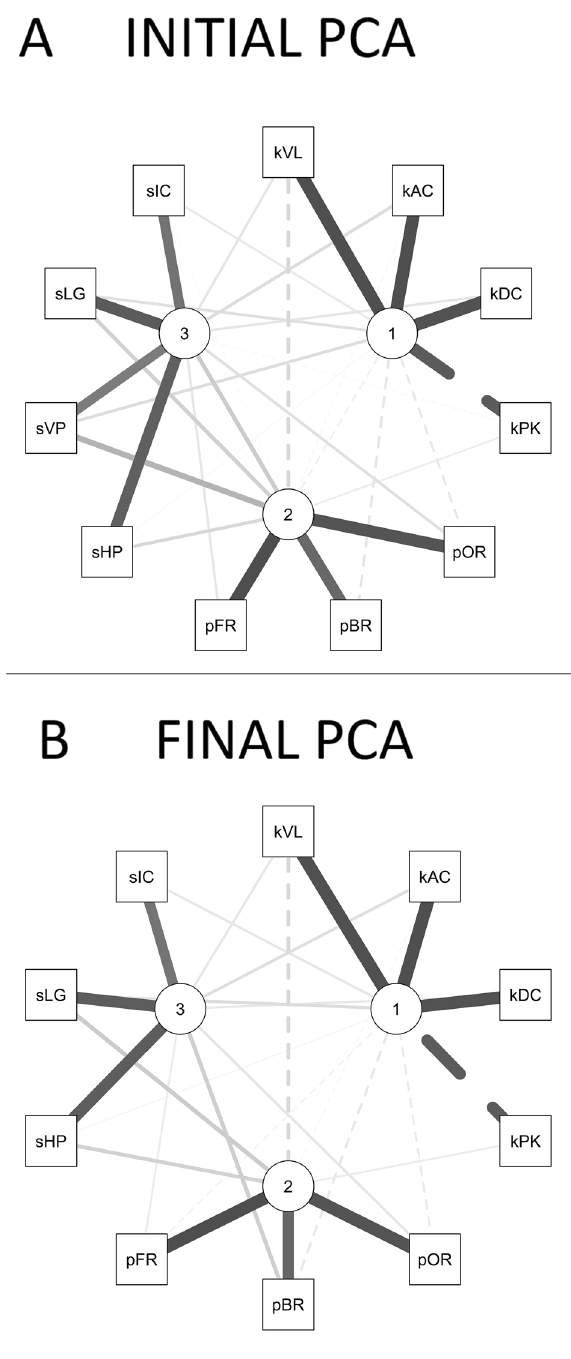
Figure 5. Relationship between indices and components. Visualisation of the relationship of the index variables and the three components extracted from the initial principal component analysis (PCA) ( A ) and the final PCA ( B ) solutions. The index variables are indicted by three-character abbreviations and the components by numbered nodes. Nodes are arranged in a way that they are closer to their more highly correlated index variables. Loading levels are indicated by the tone (from white for loading = 0 to dark grey for the highest level of loading) and the width of the lines connecting the index variables to the three components. The figures are created in RStudio (Version 1.4.1106) 80 using the package qgraph (version 1.6.9) 84 . sHP horizontal placement accuracy, sVP vertical placement accuracy, sLG length accuracy, sIC inclination accuracy, pBR base rectangle priority, pOR organisation by relevance, pFR fragmentation, kVL mean velocity, kAC mean acceleration, kDC mean deceleration, kPK number of peak